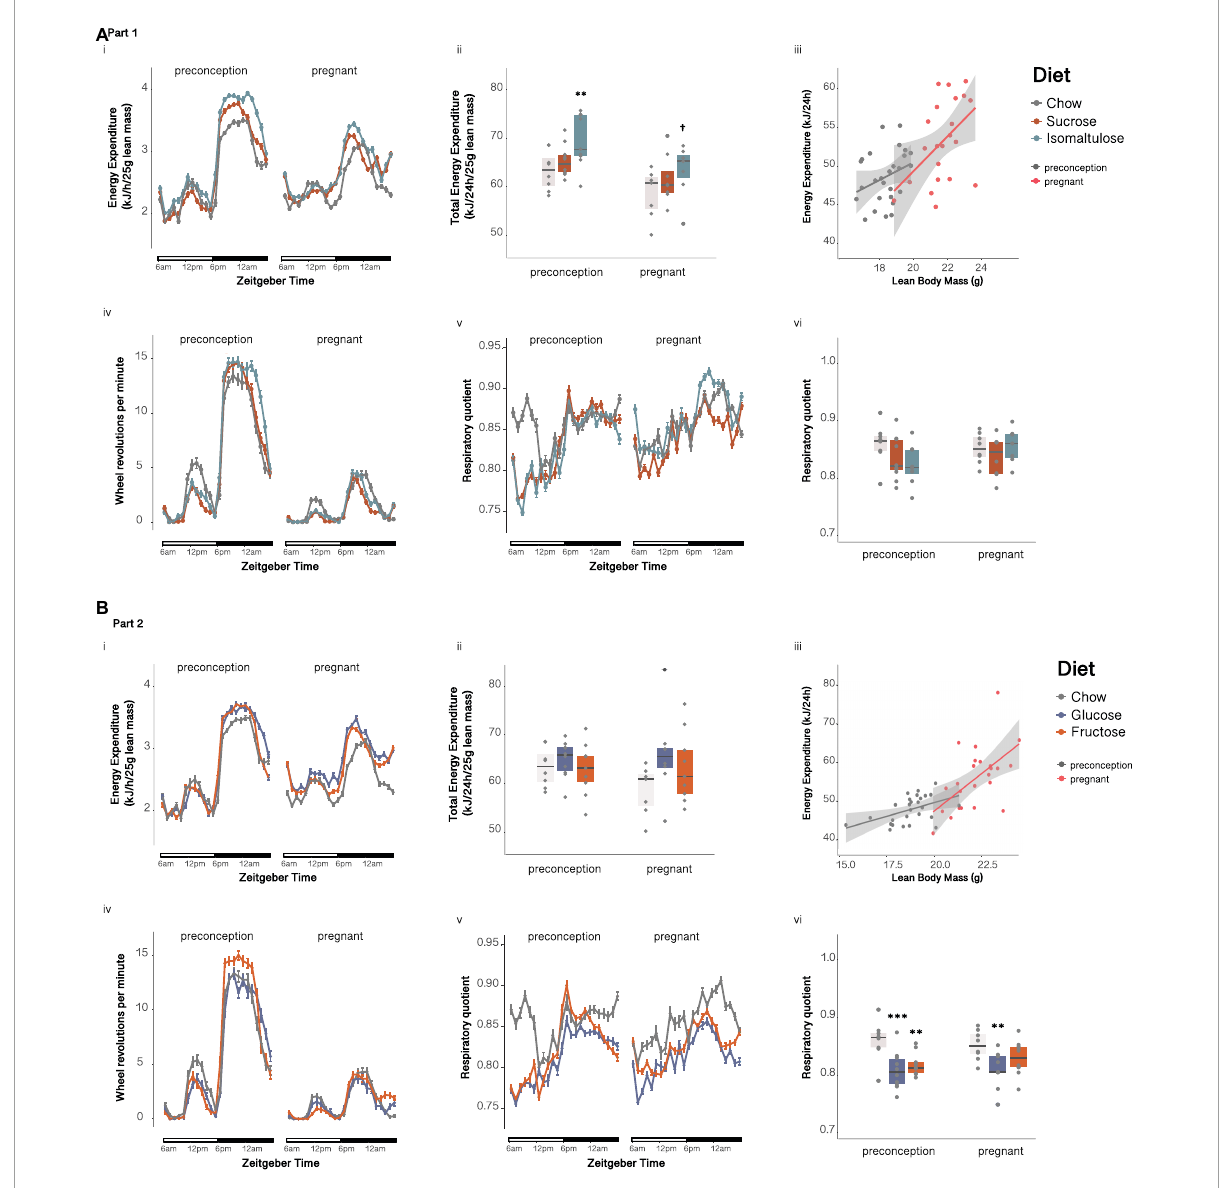
FIGURE2 Metabolic phenotyping of dams before and during pregnancy (A) in Part 1 and (B) in Part 2: Dam (i) energy expenditure over time, (ii) total energy expenditure, (iii) correlation of energy expenditure and lean mass, (iv) wheel revolutions, (v) respiratory quotient over time, and (vi) mean respiratory quotient over 24 h. n = 8–10 per diet. Line graphs depict data as mean ± SEM. ** p < 0.01 vs. chow; *** p < 0.001 vs. chow; † p < 0.05 vs. preconception for the same